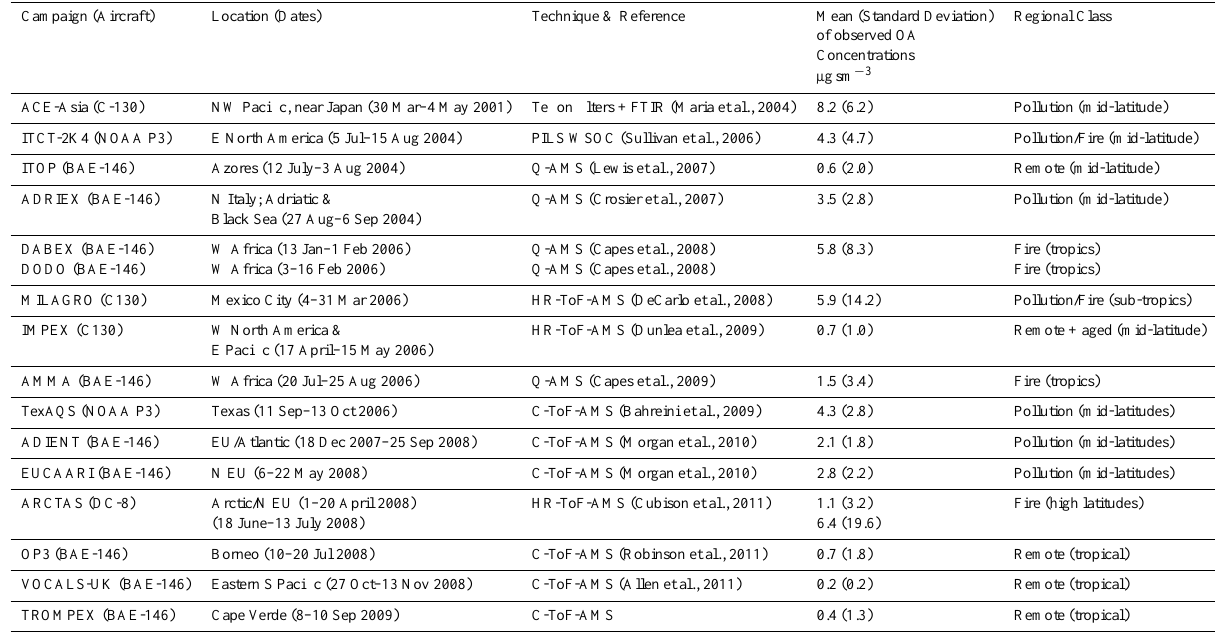
Table 1. Airborne measurements of organic aerosol